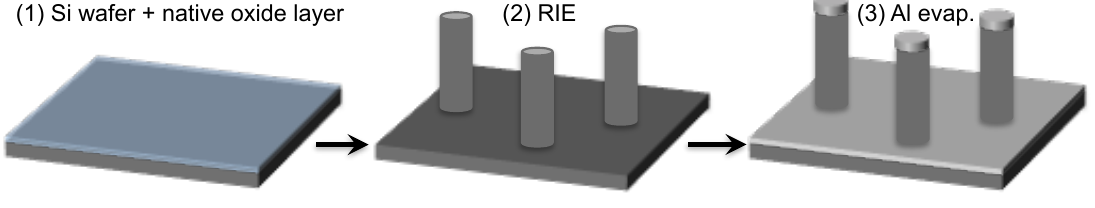
Figure 1. Principle scheme of the Al/Si nanopillar fabrication. The metal evaporation step is made under normal